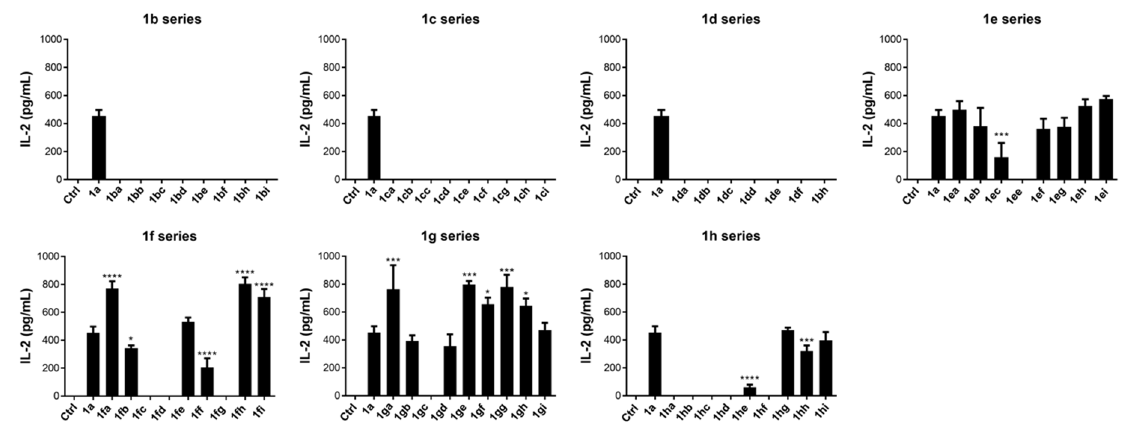
Figure 2. Bioactivity of α -GalCer and its analogs. A20 cells overexpressing mCD1d were loaded with 1 µ M of α -GalCer ( 1a ) and indicated glycolipids (from the 1b , 1c , 1d , 1e , 1f , 1g , and 1h series), and then co-cultured with murine NK1.2 cells for three days. ELISA assaying was used to determine IL-2 in the supernatant produced by glycolipid-stimulated mNK1.2 cells. All values are expressed as mean ± SD. * p < 0.05, *** p < 0.001, and **** p < 0.0001 vs. 1a by one-way ANOVA with Dunnett’s multiple comparisons test. Ctrl: DMSO.